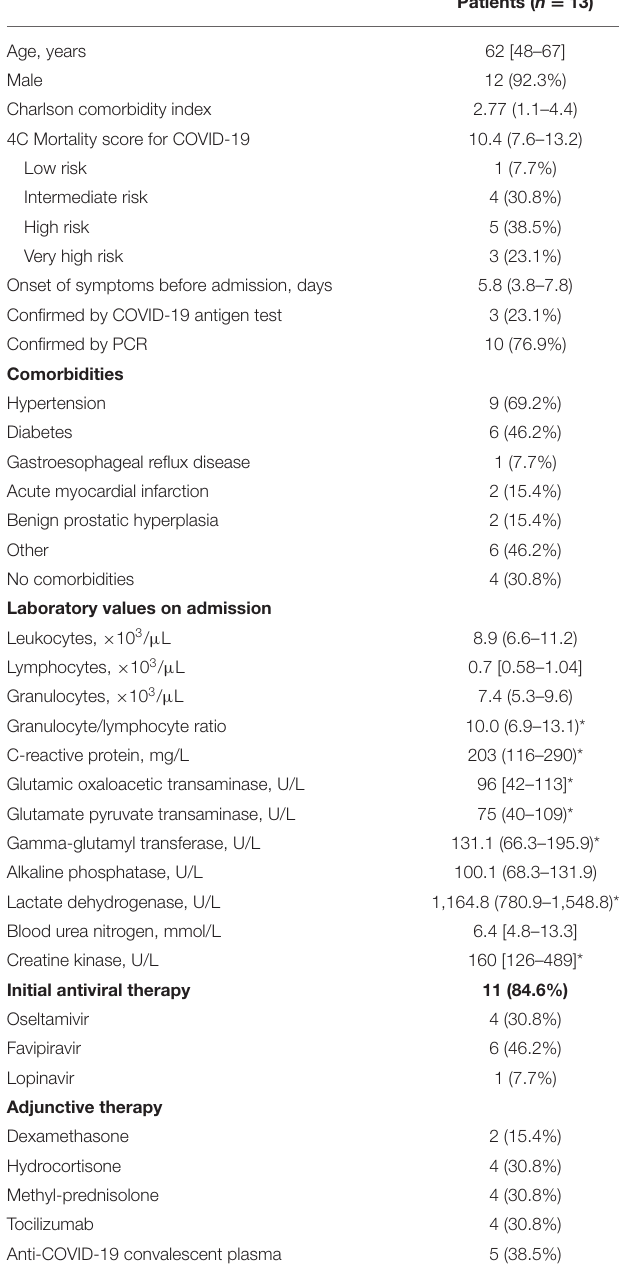
TABLE 1 | Baseline